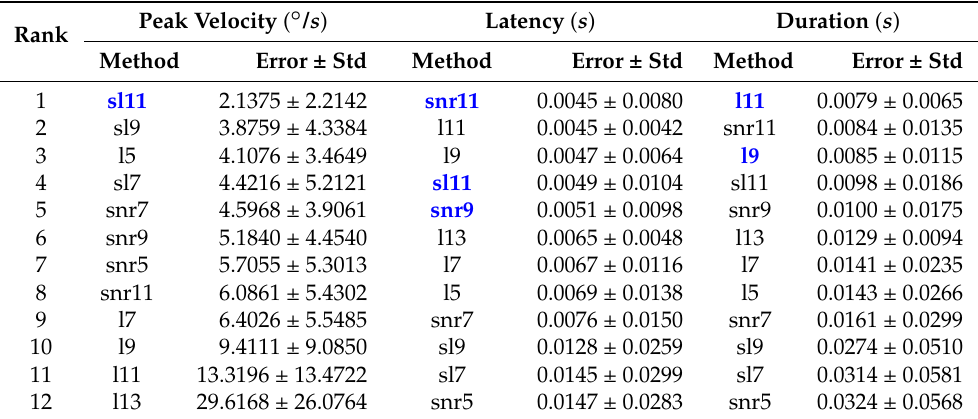
Table 2. Errors introduced by differentiation methods in saccadic biomarker computing. Methods highlighted in blue for each task are those that show no significant difference with the first ranked using the Wilcoxon post-hoc